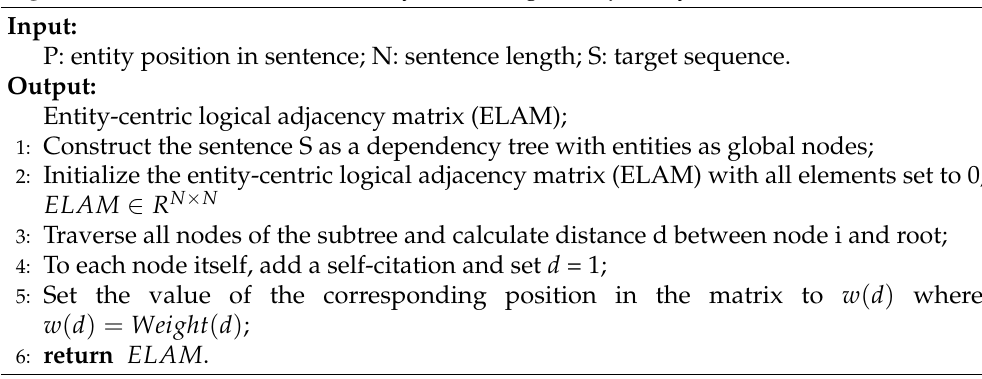
Algorithm 1 Contruction of the entity-centric logical adjacency matrix